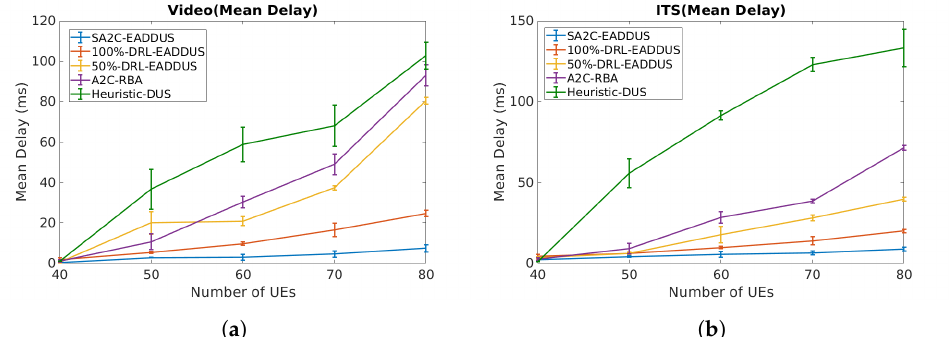
Figure 6. The overall mean delay by considering different processing capacity levels and algorithms: ( a ) the video packets’ mean delay; ( b ) the ITS packets’ mean delay.